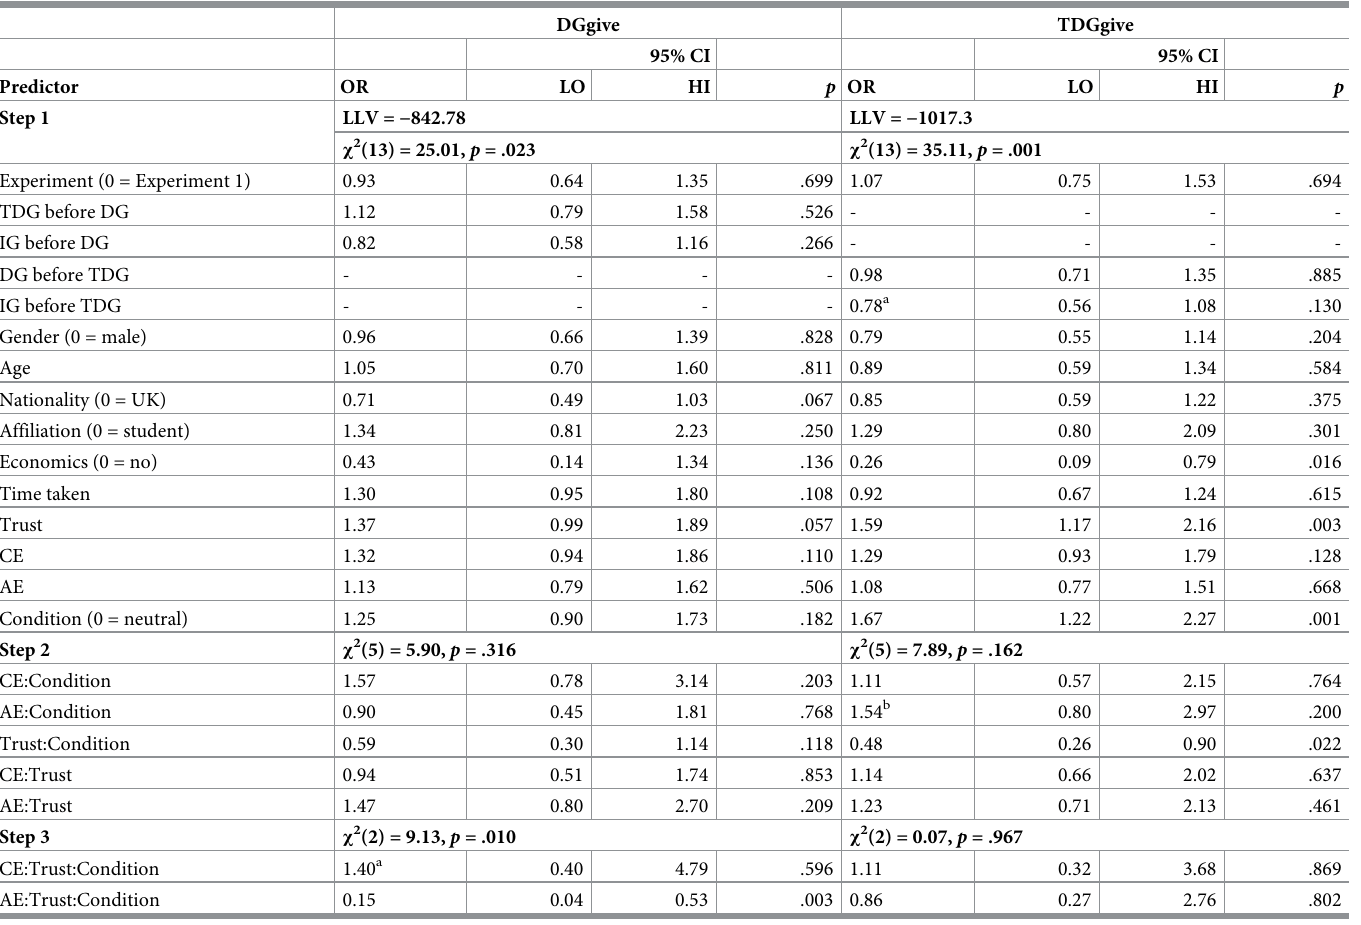
Table 2. Hierarchical ordered logistic regressions predicting giving in the DG and